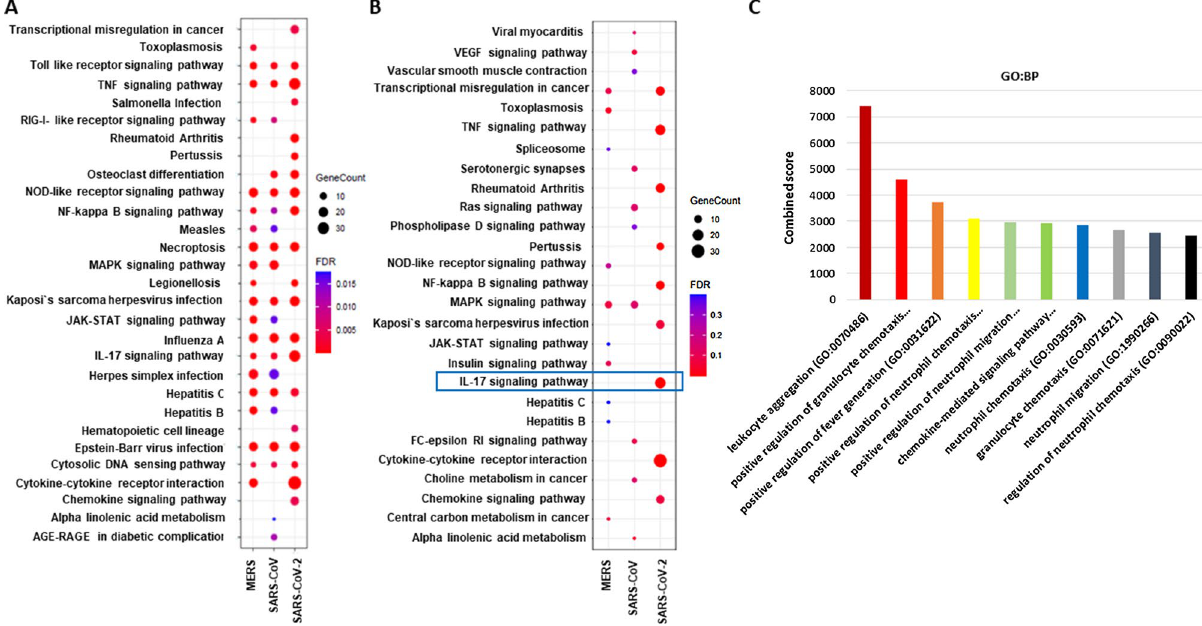
Figure 4. SARS-CoV-2 unique genes trigger IL-17 signaling pathway. ( A ) Dotplot visualization of enriched KEGG terms in SARS-CoV, SARS-CoV-2 and MERS infection showing all upregulated genes. Gene enrichment analyses were performed using Network analyst against the KEGG pathway. ( B ) Dotplot visualization of enriched KEGG terms in SARS-CoV, SARS-CoV-2 and MERS infection of uniquely upregulated genes in each infection. Gene enrichment analyses were performed using Network analyst against the KEGG pathway. The color of the dots represents the false discovery rate (FDR) value for each enriched KEGG term, and size represents the number of hit genes found in the datasets. ( C ) Barplot showing gene ontology for enriched biological process from genes upregulated in IL-17 pathway upon SARS-CoV-2 infection only. Biological processes were ranked based on combined score from the P value calculated by Fisher exact test and multiplying that with